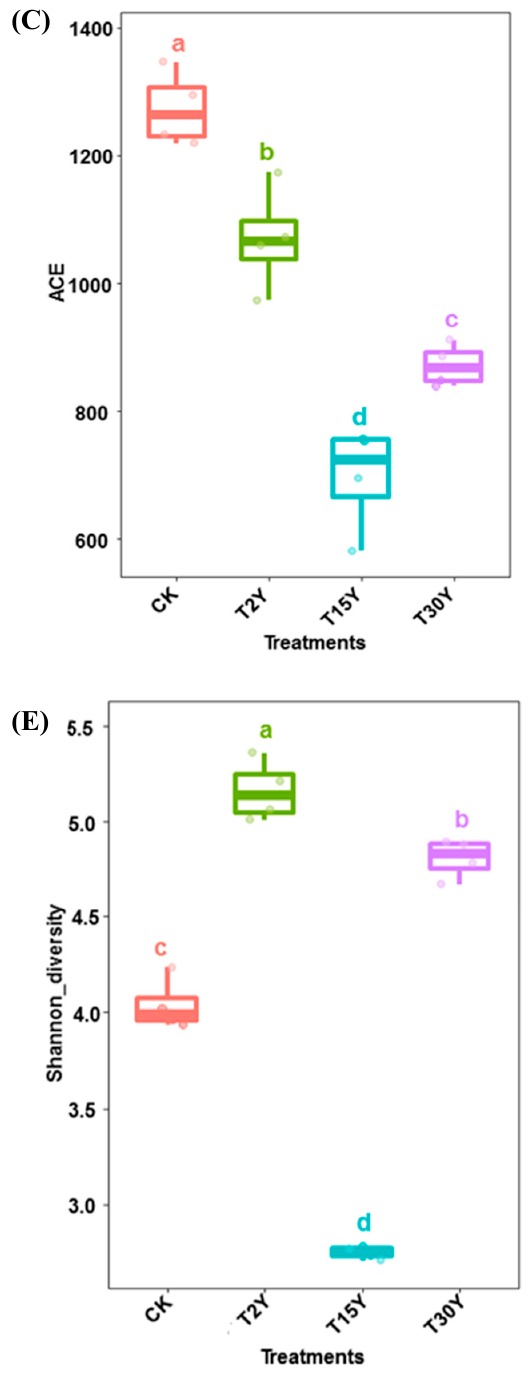
Figure 2. Box plots that represent alpha diversity indices such as fungal community richness (Chao1, observed species, ACE) and diversity (Shannon, Simpson) in the control and different age monoculture tea fields. ( A ) Chao; ( B ) observed species; ( C ) Ace; ( D ) Simpson; ( E ) Shannon. Error bars with different lowercase letters indicate significant differences among treatments based on the LSD test (*** p < 0.05). CK, T2Y, T15Y, and T30Y represent fields consecutively planted for 0, 2, 15, and 30 years, respectively.